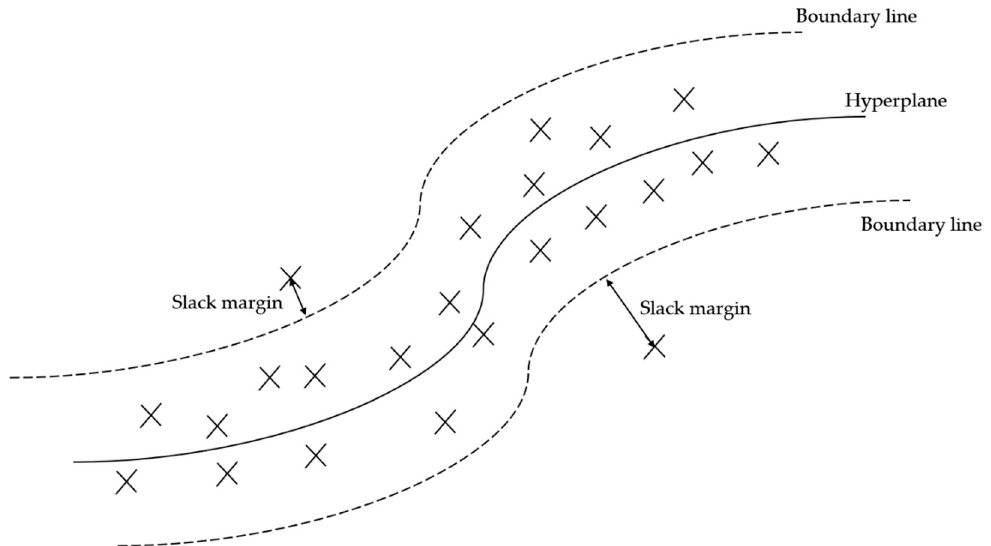
Figure 2. Configuration of a Support Vector Regression model.